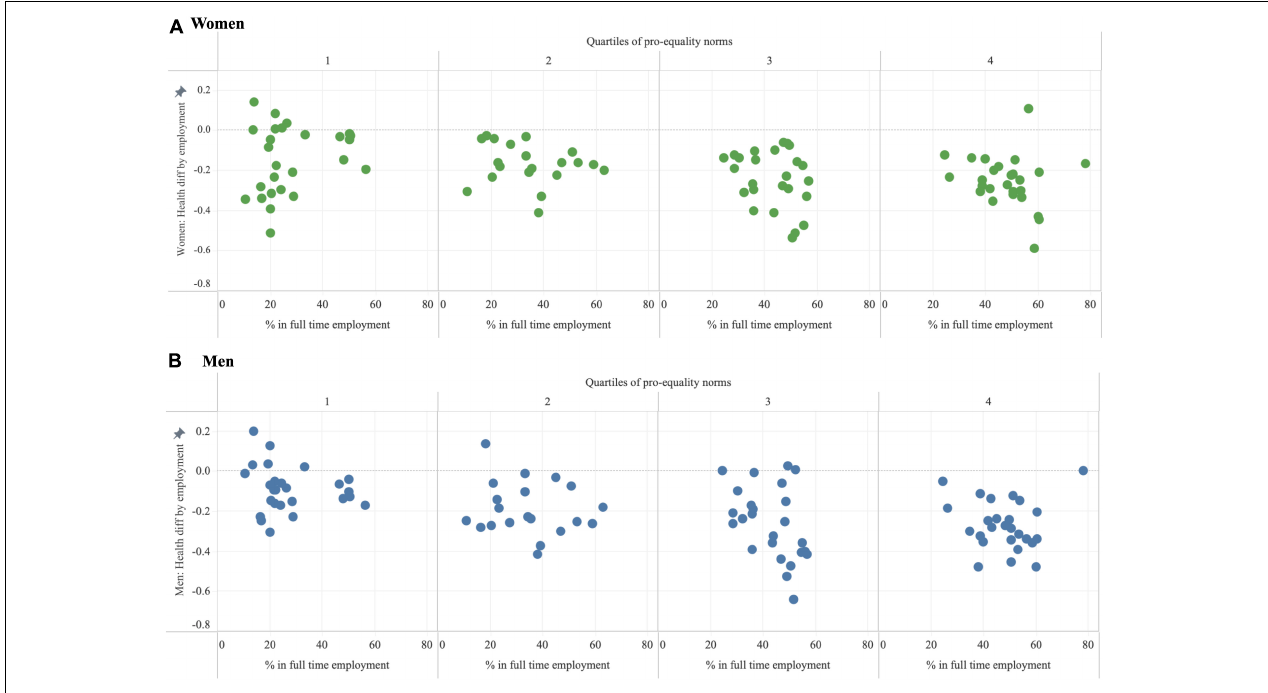
FIGURE 4 | Inequalities in self-reported health (SRH) by full time employment (FTE) among (A) women and (B) men. Negative values indicate lower self-reported health among those not in full time employment compared to those in full time employment.